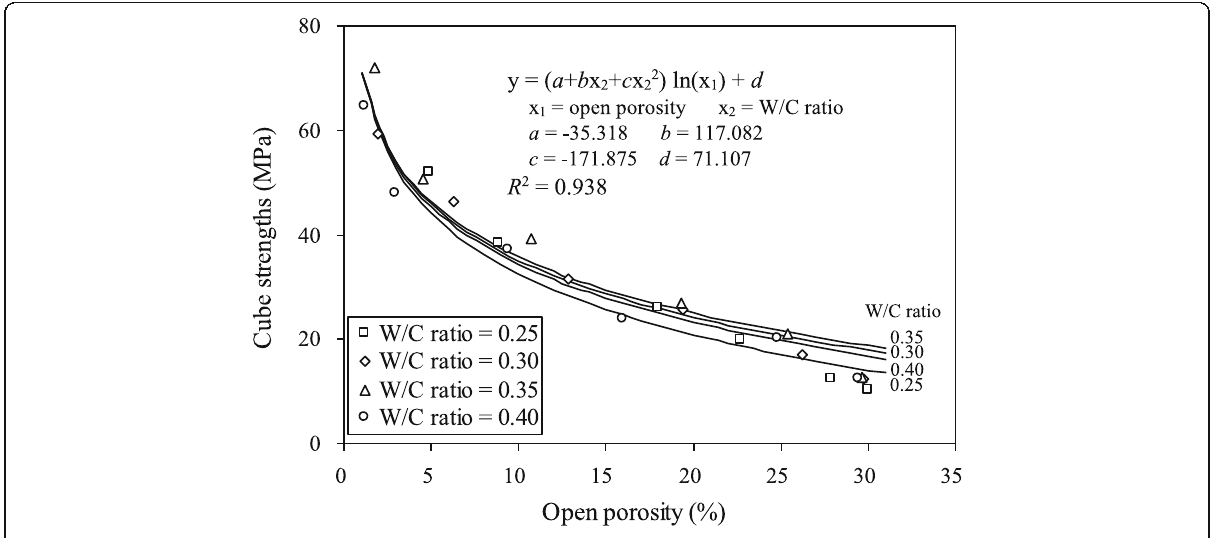
Fig. 12 Combined effects of open porosity and W/C ratio on cube